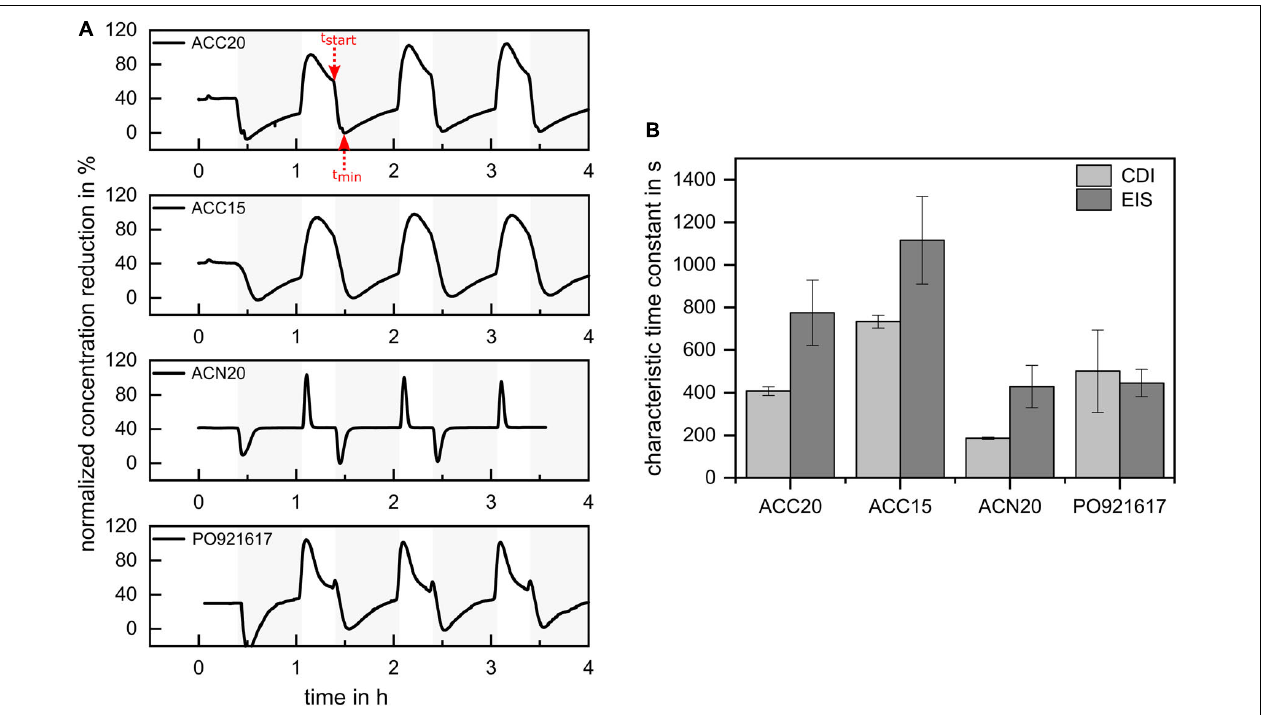
FIGURE 8 | (A) Effluent concentration profiles derived by CDI experiments. Adsorption phases are marked in light gray. The concentration profiles are normalized by setting the concentration range between the minimum during the adsorption step and the maximum during the desorption step as 100%. The observed CDI kinetics show a clear relationship toward the lower limit of the diffusion dominated frequency range in the NIF plot. (B) Comparison of characteristic time constants estimated by EIS and